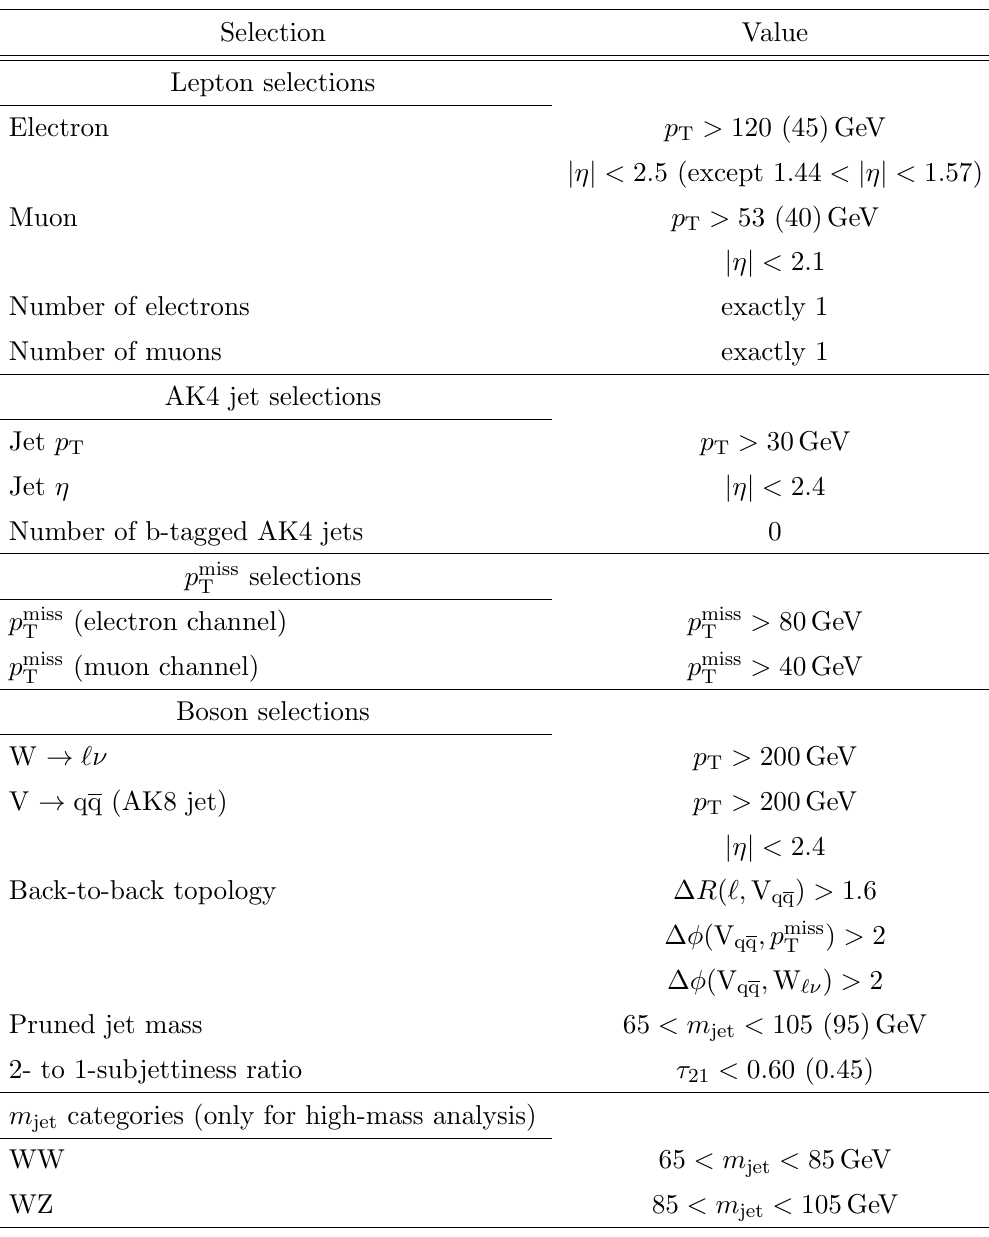
Table 3 . Summary of the (cid:12)nal selections and categories for the ‘(cid:23) +jet channel. The values indicated in parentheses correspond to the low-mass